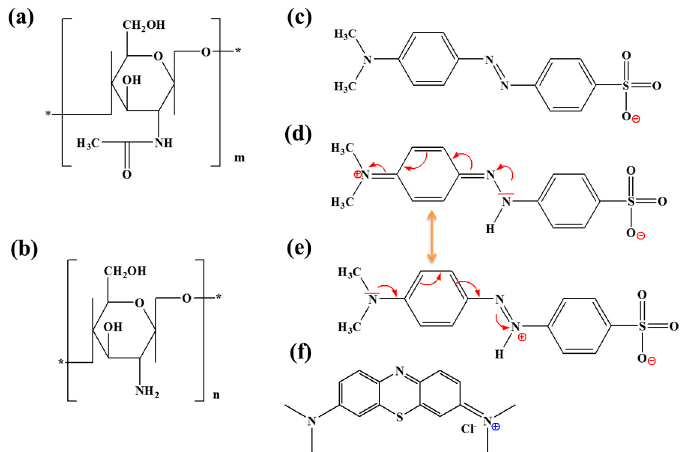
Figure 1. Chemical structure of: chitin ( a ); chitosan ( b ); anionic ( c ); zwitterionic forms of MO ( d , e ); and zwitterionic form of MB ( f ).